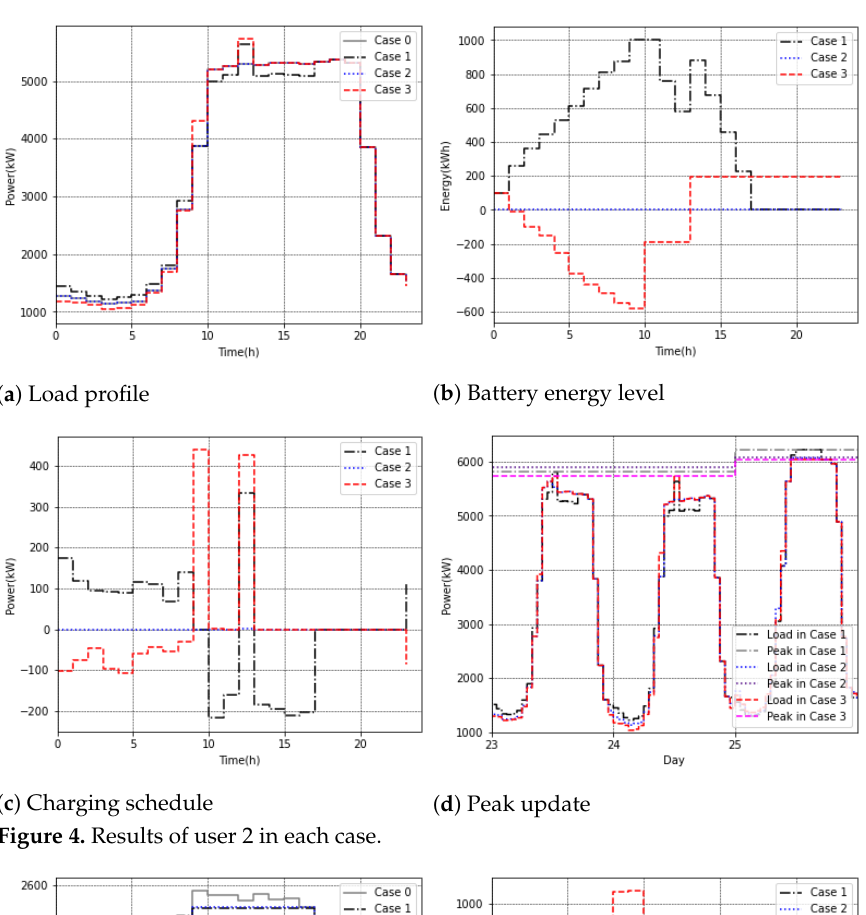
Figure 4. Results of user 2 in each case.